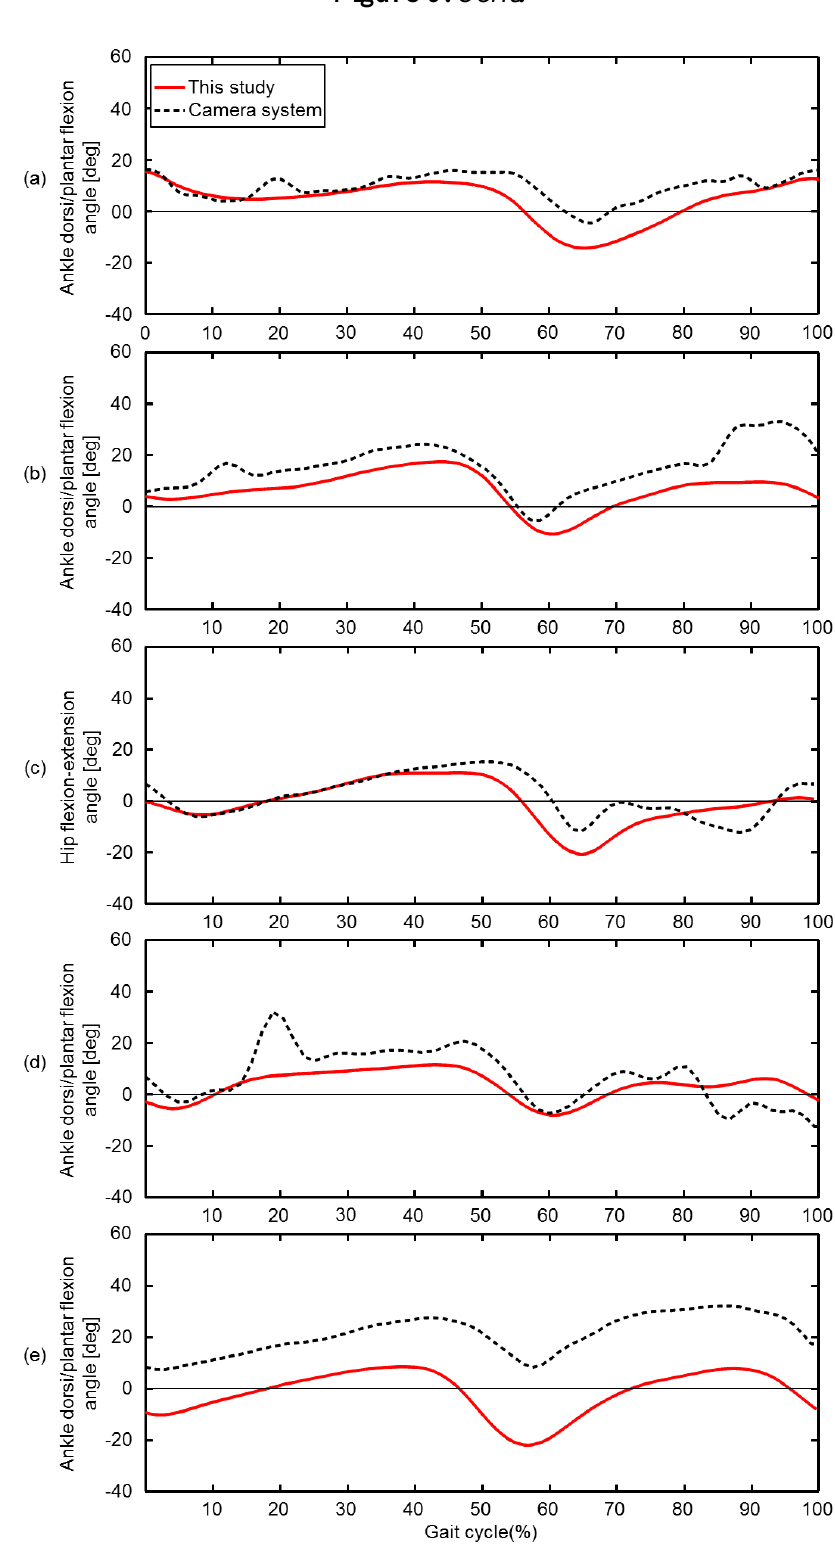
Ankle joint dorsi/plantar flexion in sagittal plane ( iii